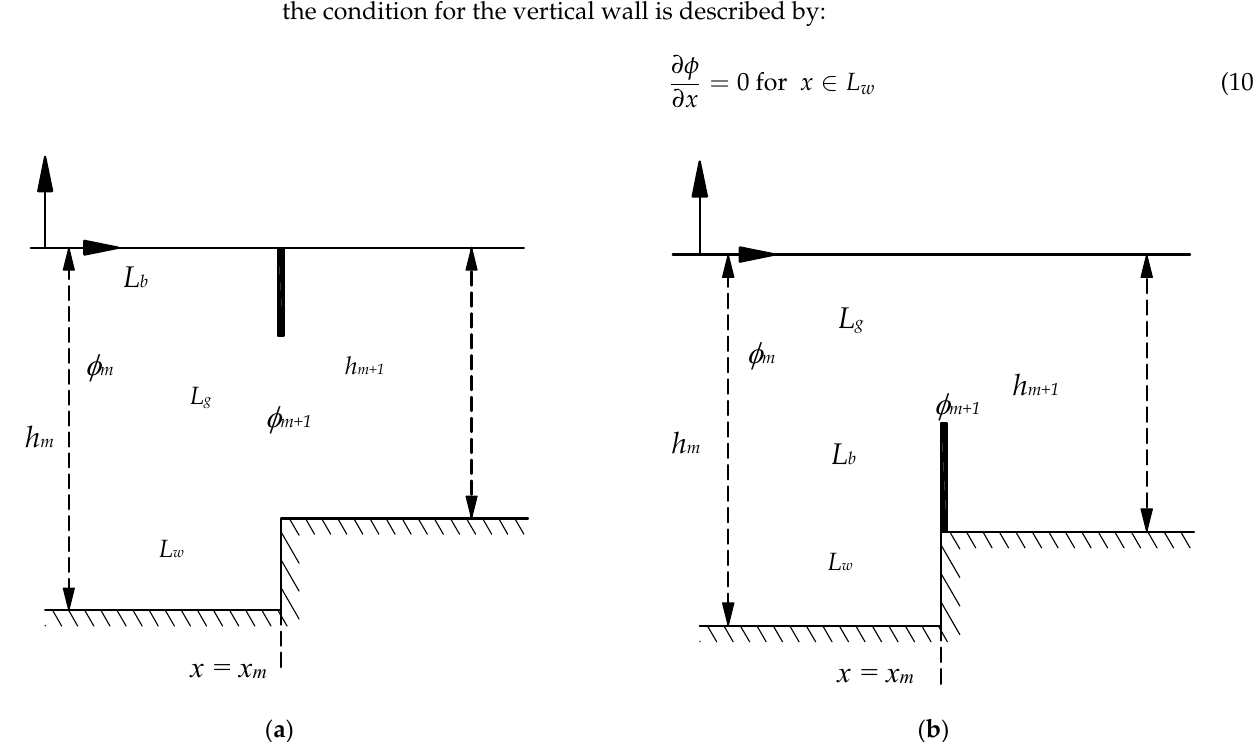
Figure 2. Definition of ( a ) surface ‐ piercing and ( b ) bottom ‐ standing barrier for separated abrupt shelves.